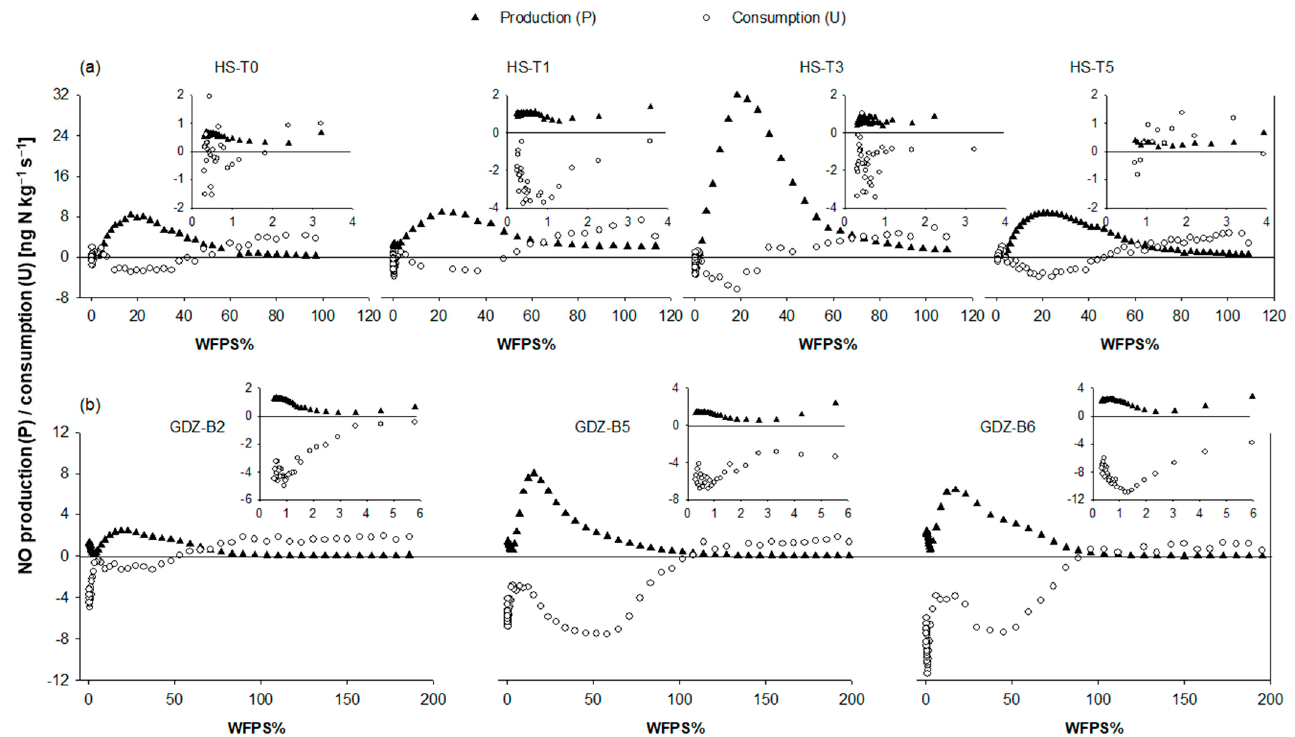
Figure 2. NO-N production (filled triangles) and consumption (calculated based on Equation (2)) (open circles) in ( a ) hillslope soils (HS-T0, HS-T1, HS-T3, HS-T5) and ( b ) soils from the groundwater discharge zone (GDZ-B2, GDZ-B5, GDZ-B6) as a function of water filled pore space (WFPS) in the dry-out experiment at 30 °C. NO production is positive, while NO consumption is negative. Positive consumption rates denote situations where the NO release rates under elevated NO mixing ratios were larger than under NO-free air. Inserts show NO production and consumption rates at < 6% WFPS. Note different scales of x- and y-axes in ( a , b ). WFPS > 100% indicates flooded soils. All soils showed a pronounced maximum in NO consumption at intermediate soil moistures. In HS soils, maximum NO consumption was observed at the same WFPS as maximum NO production (Figure 2a), whereas in GDZ soils, maximum NO uptake occurred at significantly higher WFPS values than maximum production (52.0 ± 0.9% versus 18.0 ± 2.8%). Drying the soils to below 5% WFPS (inserts in Figure 2), resulted in